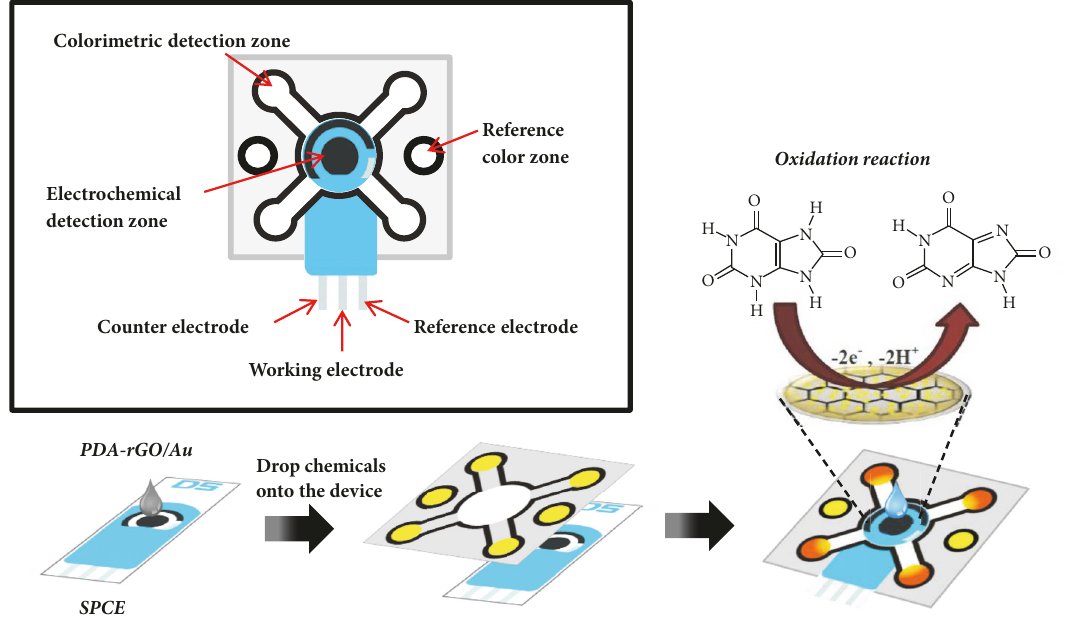
Figure 1: Diagram of 𝜇 PAD for the determination of uric acid and